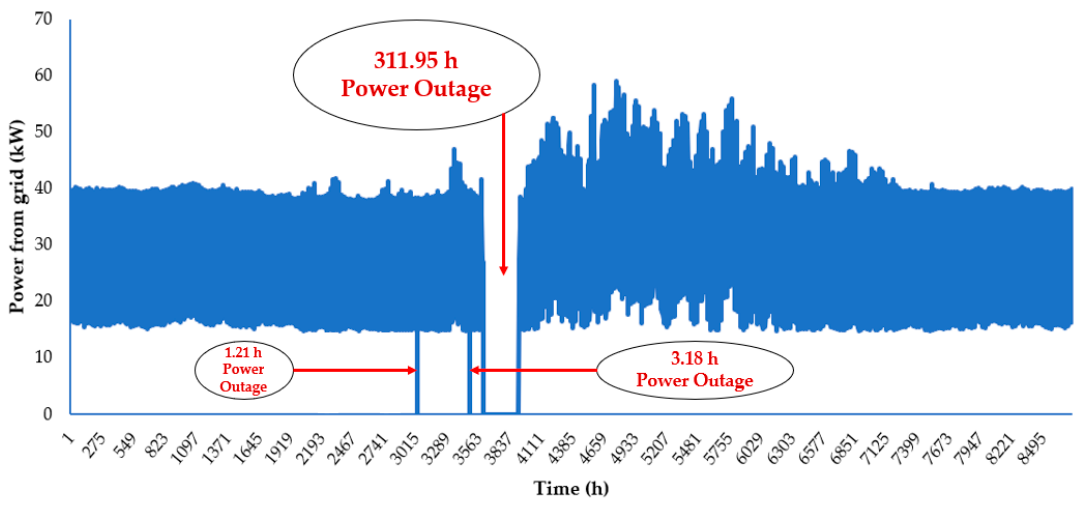
Figure 11. Electricity purchased from grid highlighting on the power outage duration for the year.